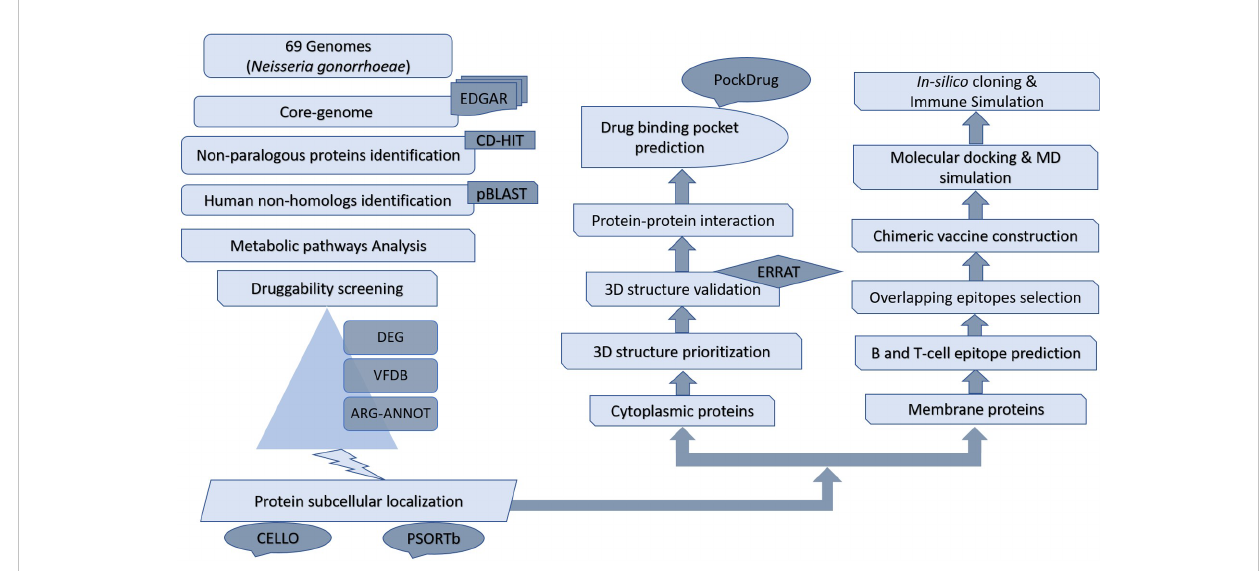
FIGURE 1 Flowchart of subtractive proteomics and reverse vaccinology approach followed for the potential drug and vaccine identi fi cations.